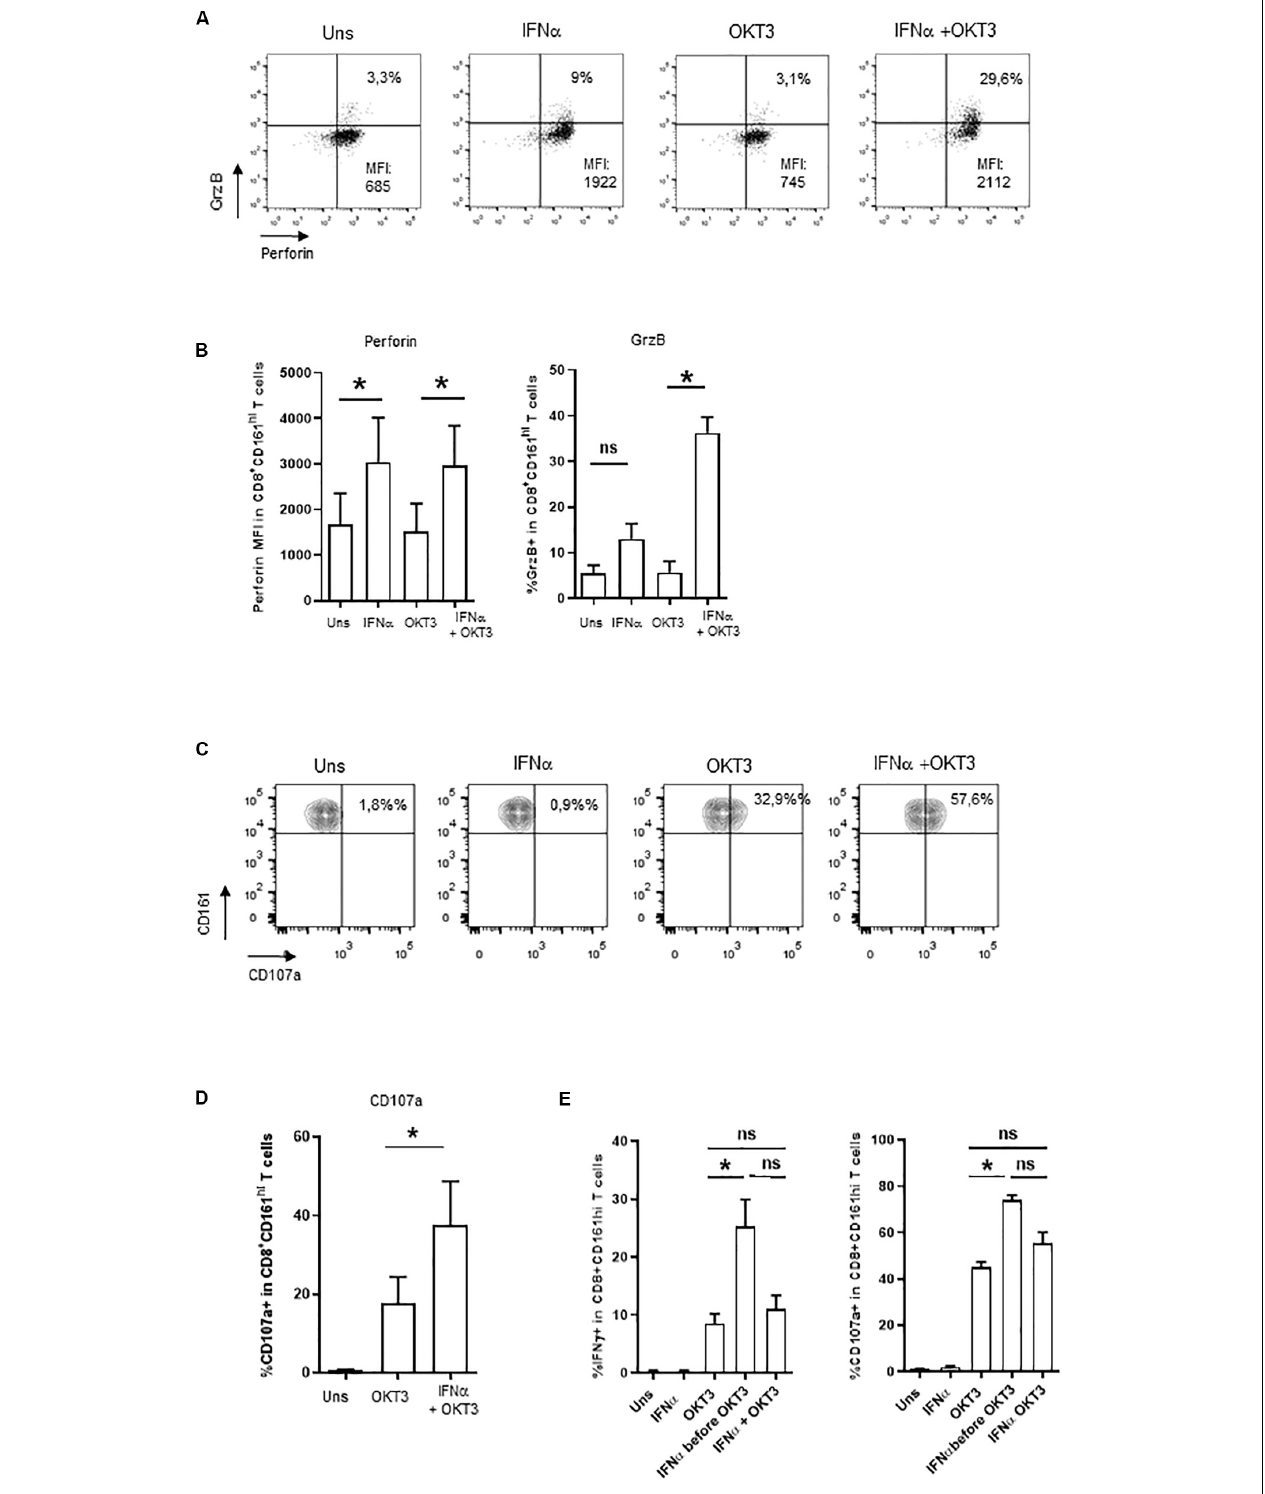
FIGURE 3 | Induction of cytotoxicity in IFN α 2b-co-stimulated CD161 hi CD8 + T cells. (A) Representative example of intracellular perforin and granzyme B expression by CD161 hi CD8 + T cells left unstimulated or stimulated under the specified conditions. (B) Cumulative data (mean ± SEM) for the mean fluorescence intensities of perforin staining (left panel) and frequencies of granzyme B + (right panel) CD161 hi CD8 + T cells, stimulated in the indicated conditions. (C) Representative example